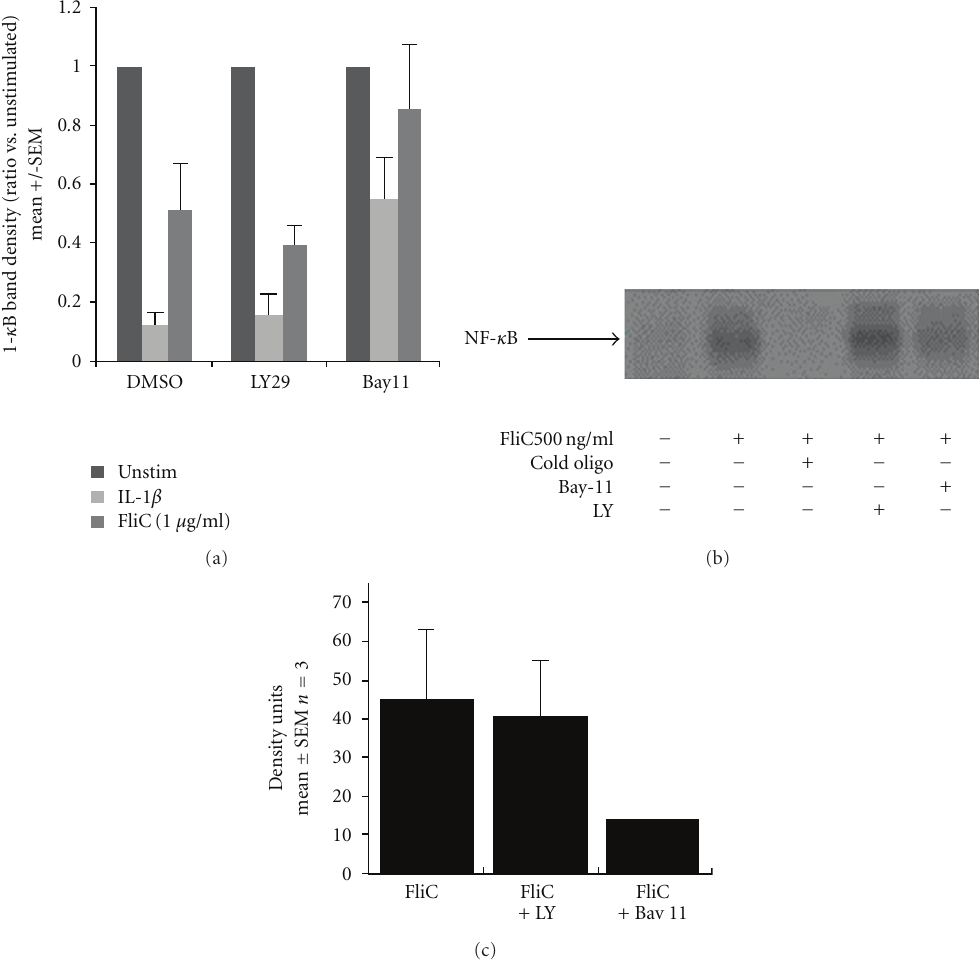
Figure 2: Flagellin-induced I- κ B degradation and NF- κ B activation in Caco-2 cells are PI3K independent. (a) I- κ B α degradation in Caco-2 cells treated with IL-1 β (10ng/ml) or flagellin (FliC, 1000 ng/ml or 500ng/ml) was not inhibited by LY29 (30 μ M) but was inhibited by Bay 11-7082 (20 μ M). Caco-2 cell lysates were analyzed by Western blot for anti-I κ B α and anti-GAPDH and the band density measured. Density of I- κ B bands was divided by GAPDH to normalize for protein loading and transfer, and the ratio was taken versus unstimulated cells in each experiment to calculate the amount of I- κ B α degradation. Results were pooled from four separate experiments. P < . 01 versus DMSO by ANOVA, DMSO + FliC versus Bay11 + FliC. (b) NF- κ B activation in Caco-2 cells measured by electrophoretic mobility shift assay, with the shifted NF- κ B band indicated by the arrow. (c) Densitometry measurements of NF- κ B-bound probe bands, pooled from 3 independent